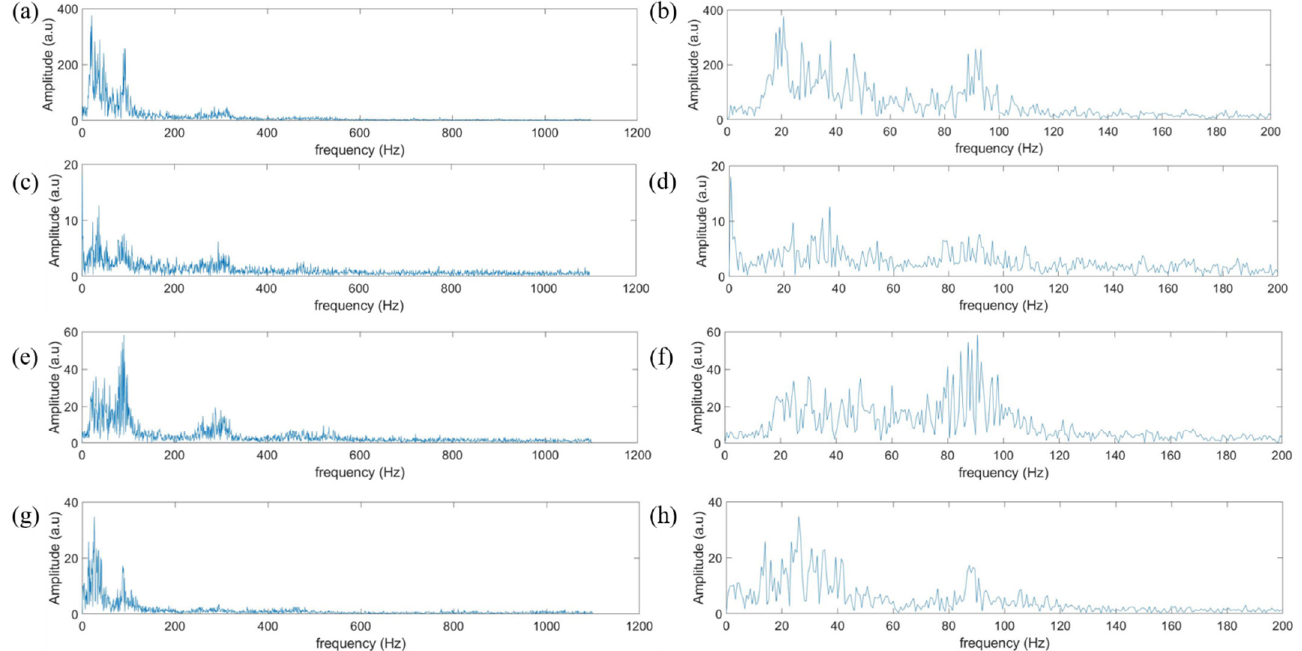
Figure 5. Frequency domain signals of polyester ( a ), lambswool ( c ), cotton linen ( e ), foam ( g ). The zoom in view of the signals in 0–200 Hz for polyester ( b ), lambswool ( d ), cotton linen ( f ), foam ( h ).